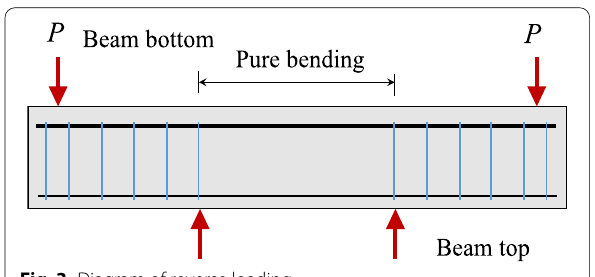
Fig. 3 Diagram of reverse loading.